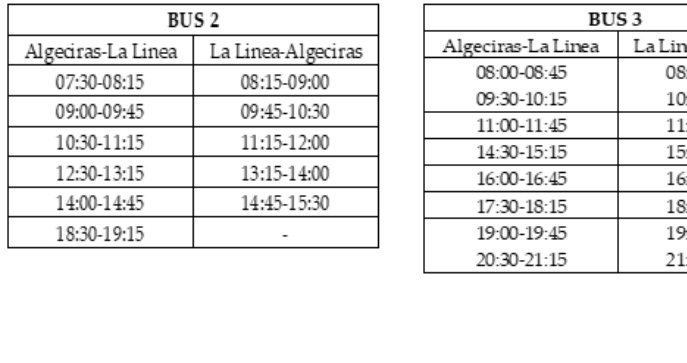
Figure 15. Timetables of the three buses.